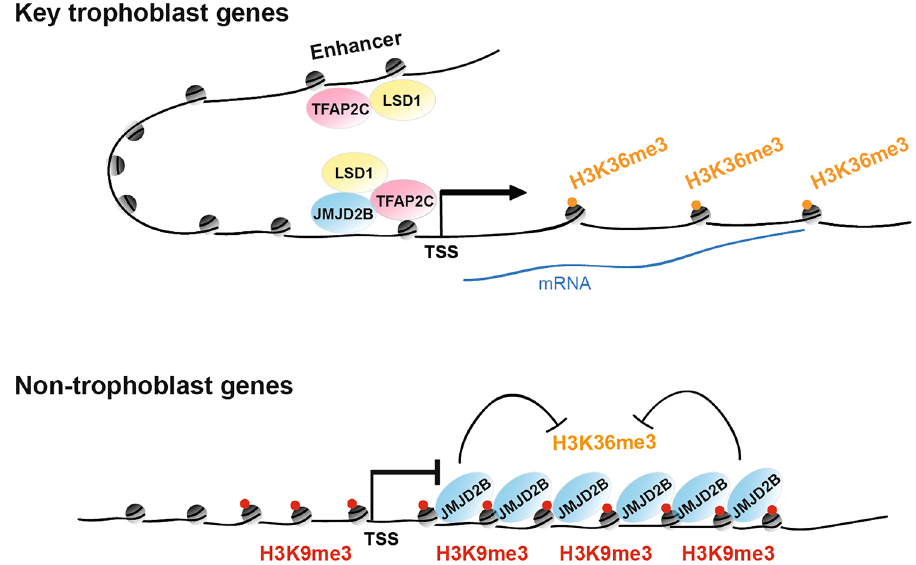
Figure 6. A model of the dual function of JMJD2B for the transcriptional regulation in TSCs. At the promoters of key trophoblast genes, JMJD2B forms a transcriptional activator complex with TFAP2C and LSD1, which may interact with the TFAP2C–LSD1 complex at enhancer, to maintain active gene expression. At the gene bodies of non-trophoblast genes, JMJD2B is co-enriched with the repressive H3K9me3 mark, and mediates H3K36 demethylation for silencing of unrelated lineage fate. The drawing was created originally using Microsoft